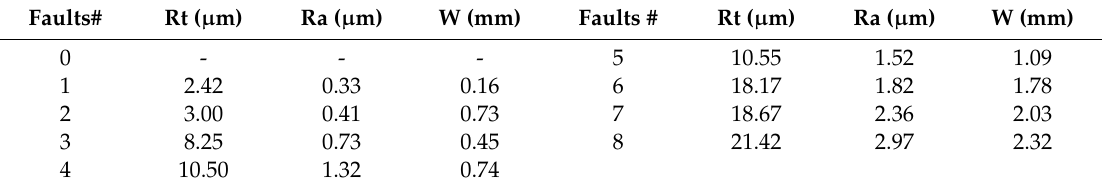
Figure 9. Experimental validation ( a ) Iteration 10, ( b ) Iteration 11 and ( c ) Iteration 90.